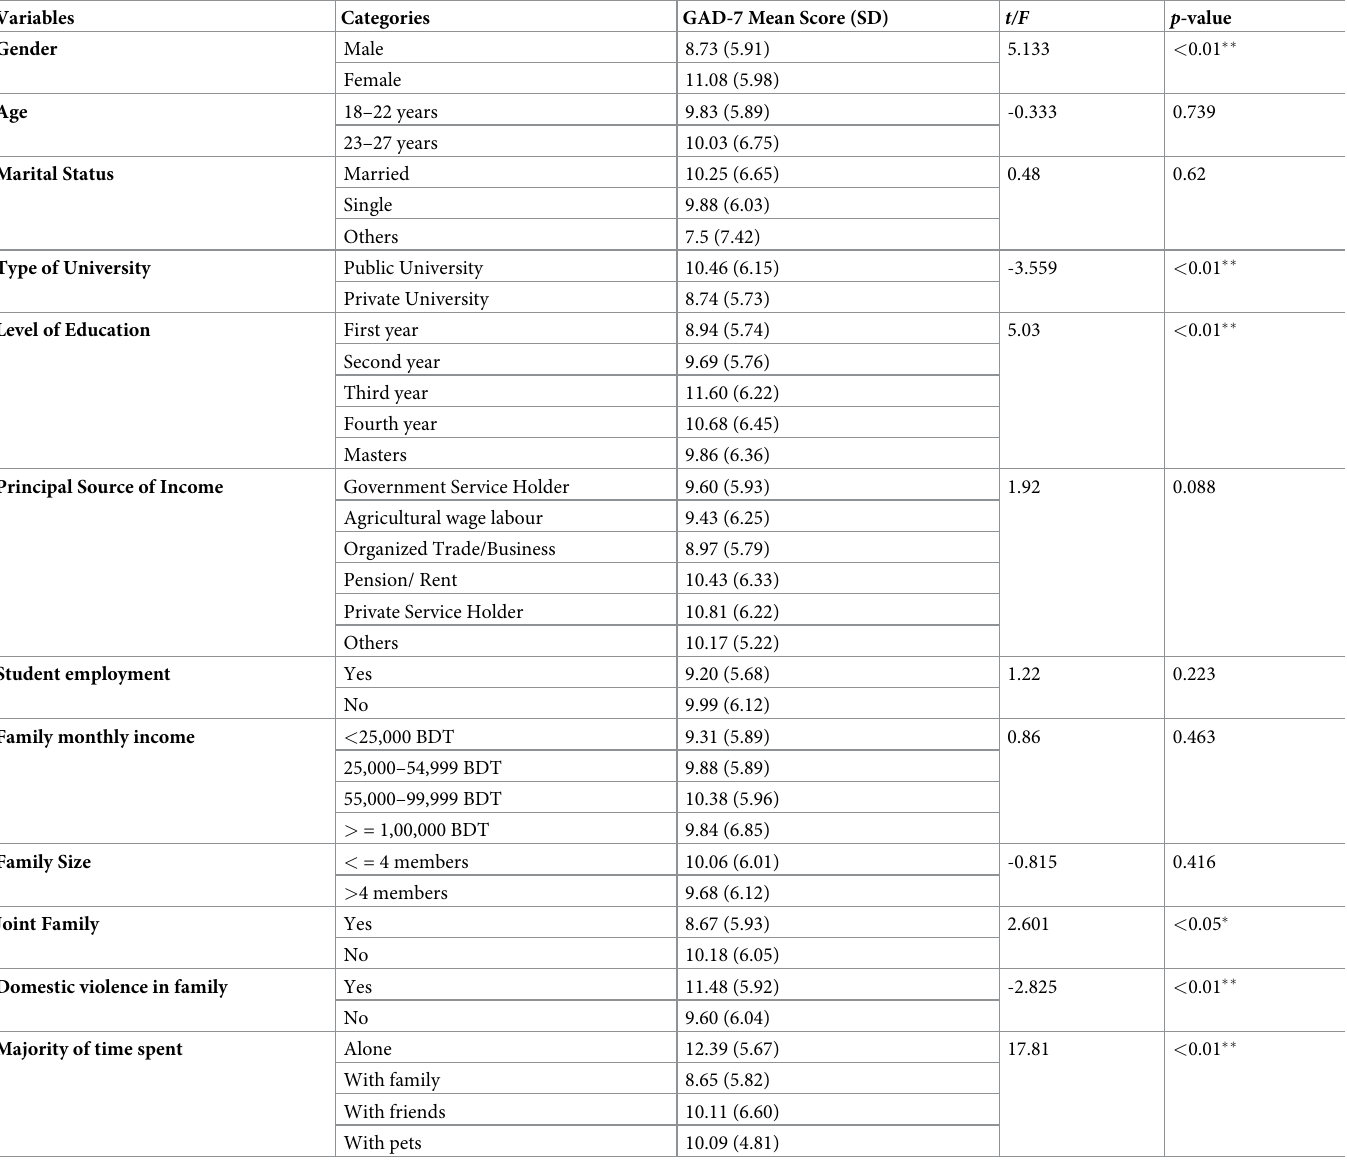
Table 4. Association of GAD-7 scores with socio-demographic characteristics ( n =